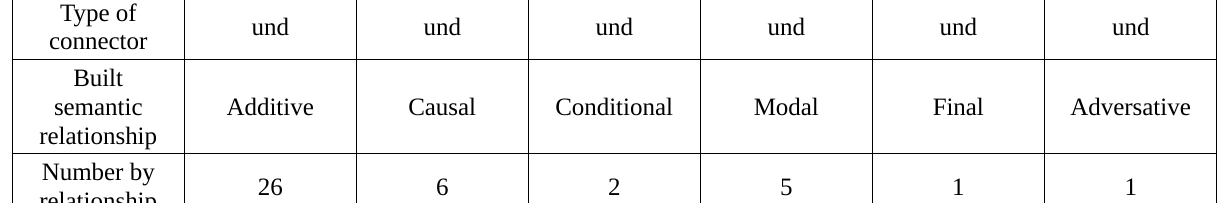
Table 2 - Quantitative proportions of semantic variations